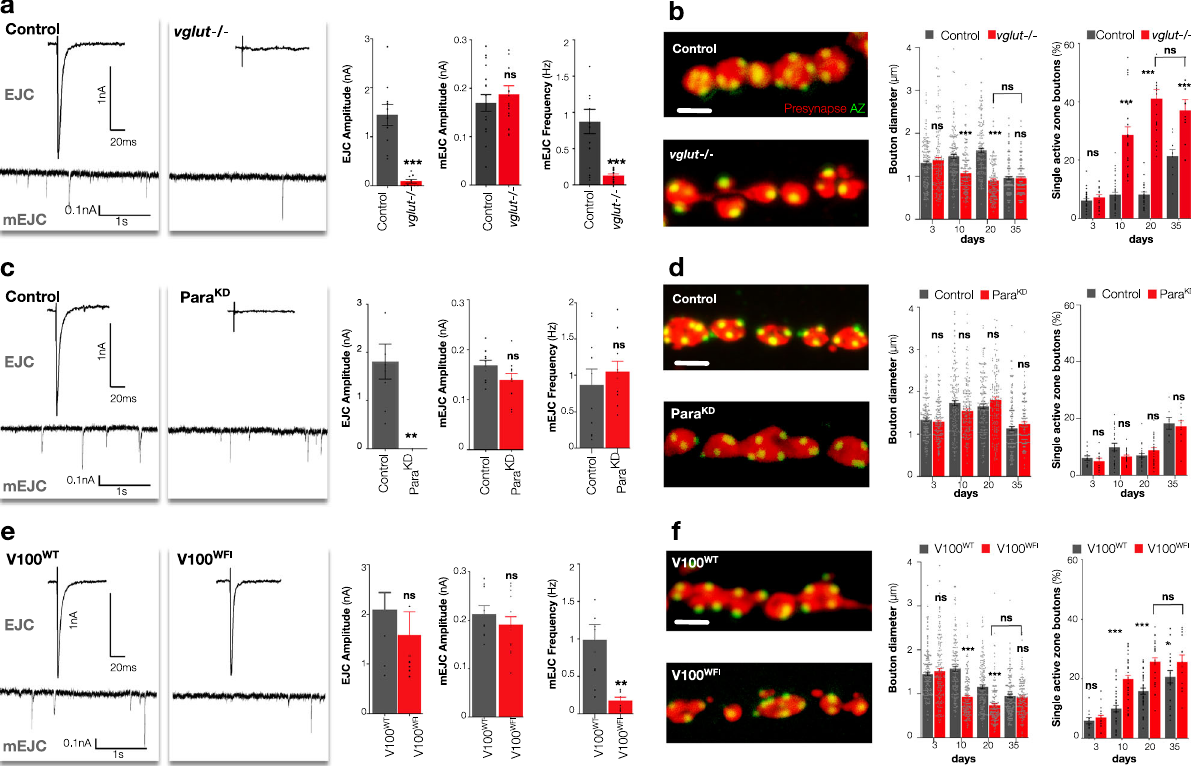
Fig. 3 Miniature but not evoked neurotransmission is required for adult synapse maintenance. a Representative EJC (above) and mEJC (below) traces, quanti fi cation of EJC amplitude, mEJC amplitude and frequency of control [UAS > GFP/ + ; HB9 > Gal4, Tub > Gal80 ts ] and HB9 neuron selective